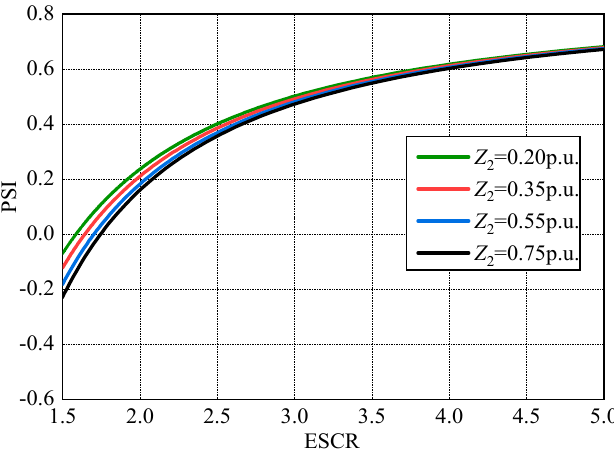
Figure 7. Curves of PSI versus ESCR for different Z 2 under VSC-HVDC constant reactive power control mode.